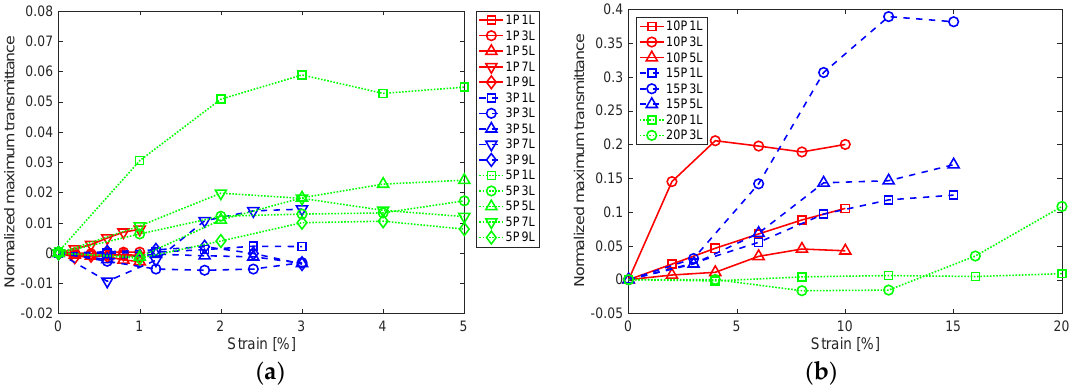
Figure 8. Normalized maximum transmittance change is shown with applied strain for the corrugated PEDOT:PSS thin film specimens, which were fabricated at ( a ) low pre-strain up to 5% and ( b ) high pre-strain up to 20%.